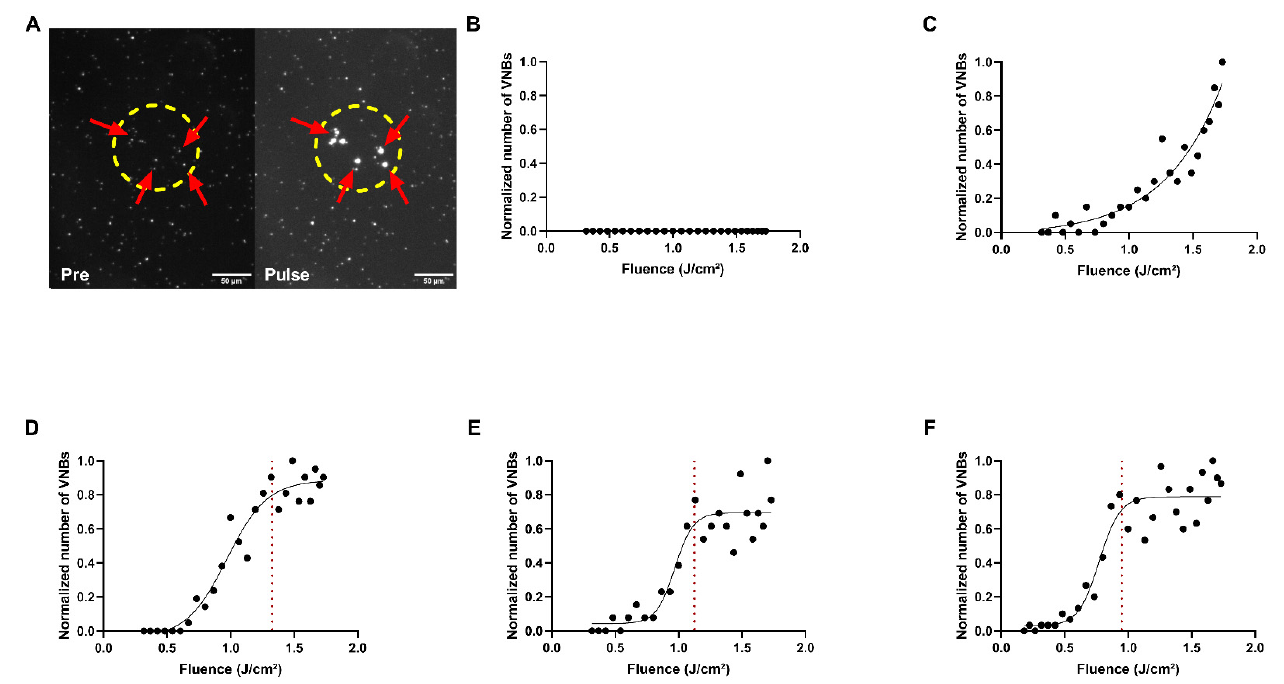
Figure 3. VNB formation by PDNPs. ( A ) Visualization of vapor nanobubbles (VNBs) (red arrows) by dark field microscopy before (pre) and upon (pulse) local laser irradiation with a fluence of 1 J/cm 2 in a 500 nm PDNP dispersion (dashed yellow circle). ( B – F ) VNB formation as a function of laser pulse fluence for 142 nm ( B ), 300 nm ( C ), 500 nm ( D ), 700 nm ( E ) and 858 nm ( F ) PDNPs. By fitting a Boltzmann curve (solid black curve), the VNB threshold (dashed red line) could be determined for 500 nm, 700 nm and 858 nm PDNPs. Scale bar = 50 µm.